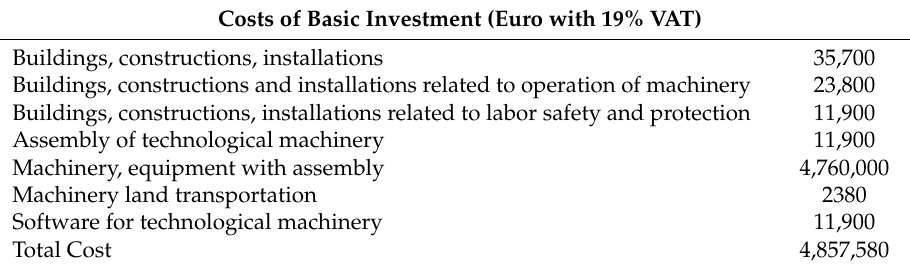
Table 4. MSW investment cost.